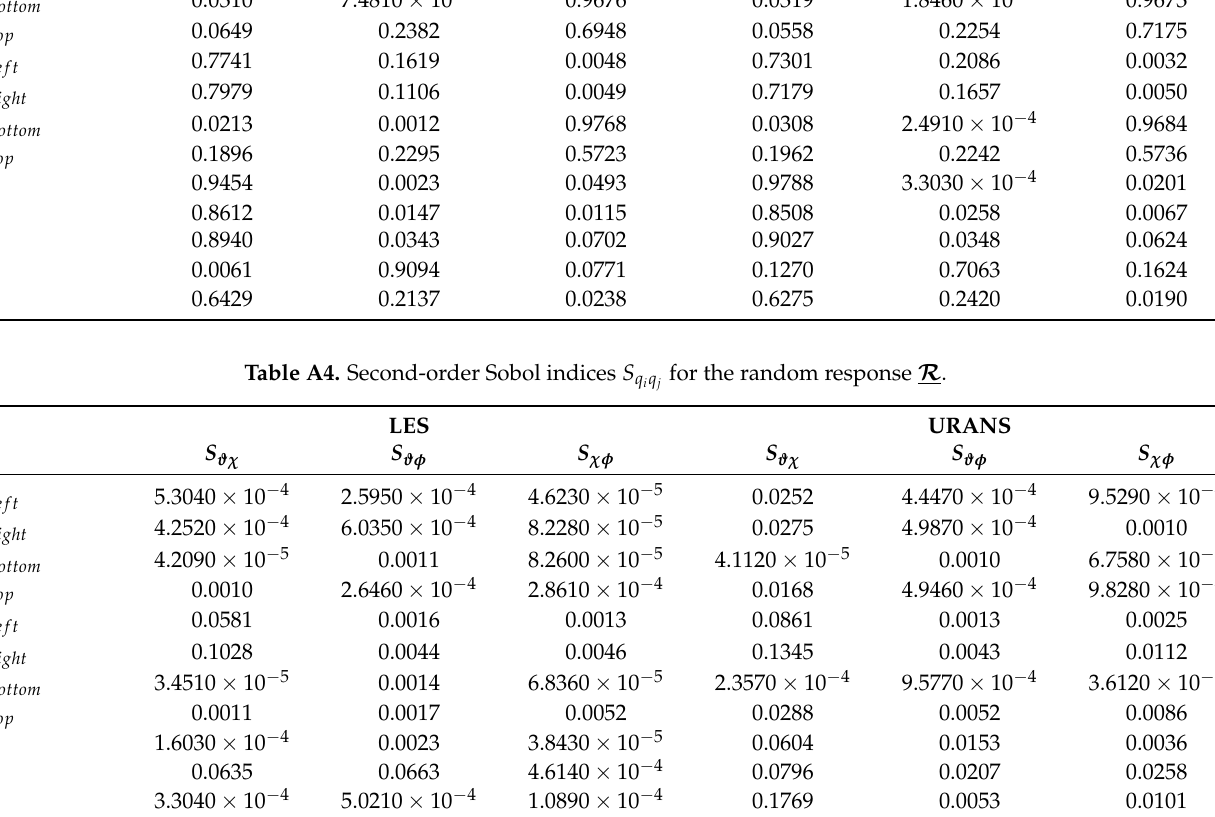
Table A5. Total-order Sobol indices S T